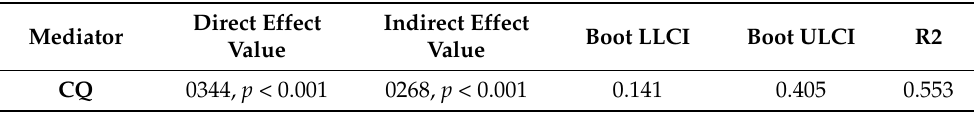
Table 5. Controlling quality as the mediator of the relation between controlling dynamic capabilities and organizational